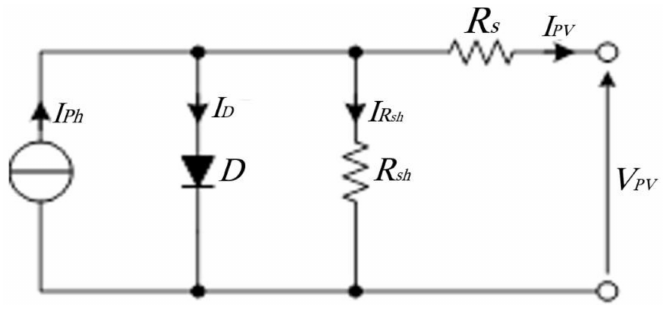
Figure 1. PV cell